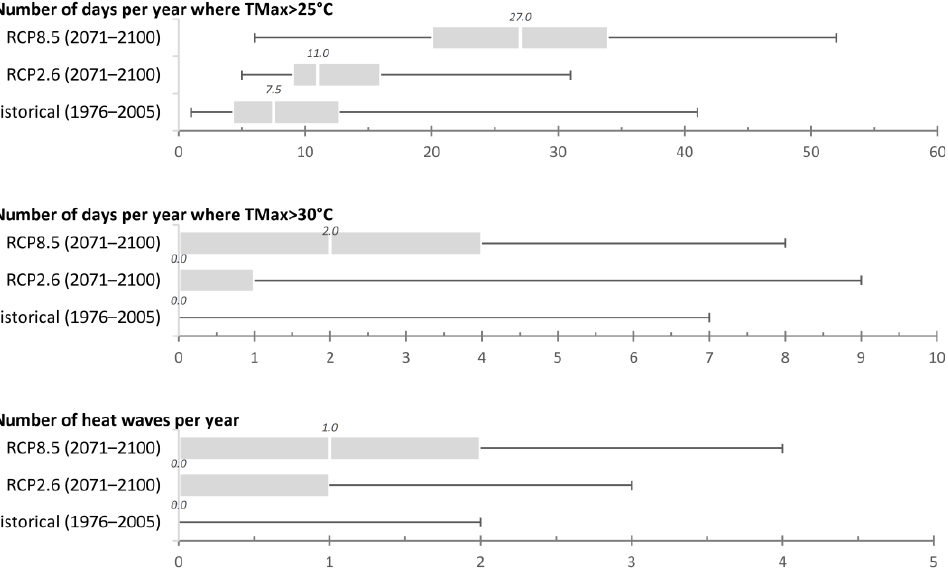
Figure 6. Evolution of the number of days reaching 25 °C or 30 °C and the number of heatwaves per year according to historical (1976 – 2005), RCP2.6 (2071 – 2100) and RCP8.5 (2071 – 2100) scenarios in Uccle (Belgium).